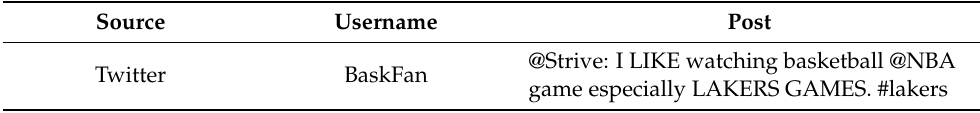
Table 2. One example of a tweet including user